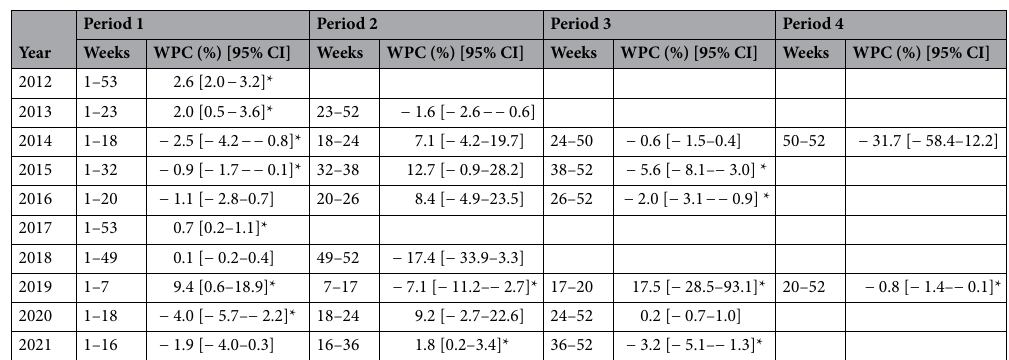
Table 2. Weekly percentage changes (WPC) in relative search volumes (RSV) of “Shikyuu-keigan (cervical cancer)” in “All category”, by each year, 2012–2021. SE, standard error; CI, confidence interval. *Significantly different from zero ( p <